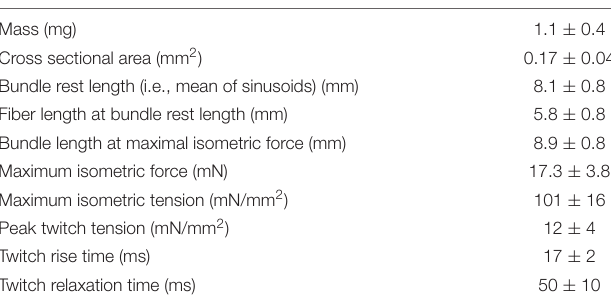
TABLE 1 | Mean ± SD of bundle characteristics ( N =